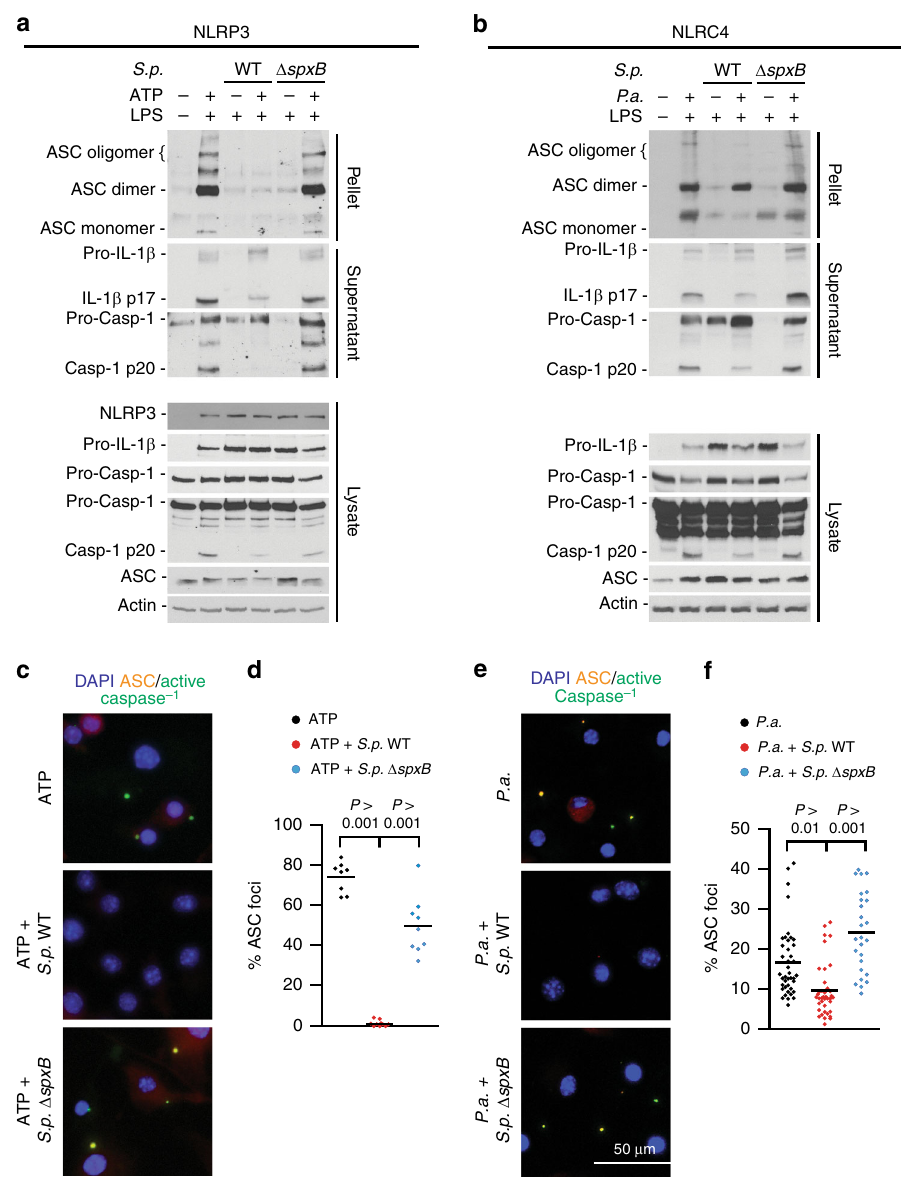
Fig. 4 In fl ammasome inhibition by S. pneumoniae involves defects in ASC complex formation. a , b Immunoblot analyses of ASC oligomers or Caspase-1 and IL-1 β processing in LPS-primed BMDMs pre-treated with S.p . WT or S.p . Δ spxB (D39, MOI 50, 30 min) before stimulation with a ATP for 30 min (NLRP3) or b P.a . (NLRC4, MOI 20) for 60 min. Results are representative of 3 independent experiments. c – f Microscopic visualisation of ASC/active Caspase-1 complexes (red/green; overlay yellow) in LPS-primed BMDMs pre-treated with S.p . WT or S.p . Δ spxB (D39, MOI 50) and subsequently stimulated with c , d ATP (5 mM, 30 min) or e , f P.a . (MOI 20, 60 min). Panels d and f depict corresponding percentages of cells in c and e , respectively, containing ASC/active Caspase-1 specks (determined by enumerating at least 100 cells per sample). Scale bar: 50 µ m. Results in d and f are from three independent experiments. The data are shown as the mean ± s.e.m. P values determined by one-way ANOVA followed by Bonferroni post-test. Source data are